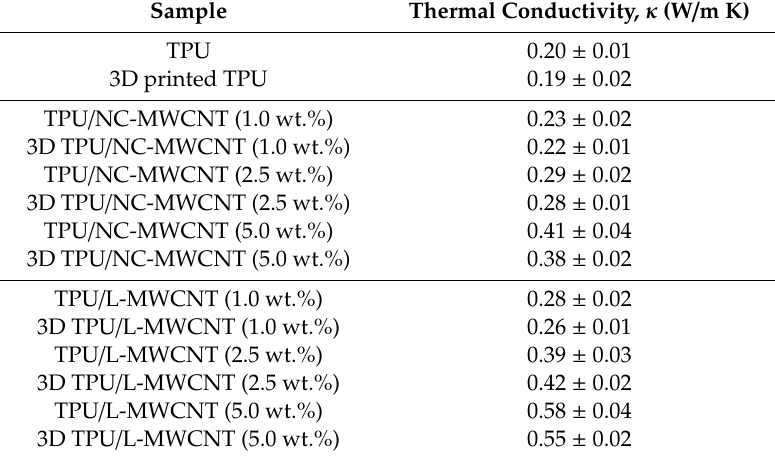
Table 2. Thermal conductivity of the extruded TPU, TPU / NC-MWCNT and TPU / L-MWCNT